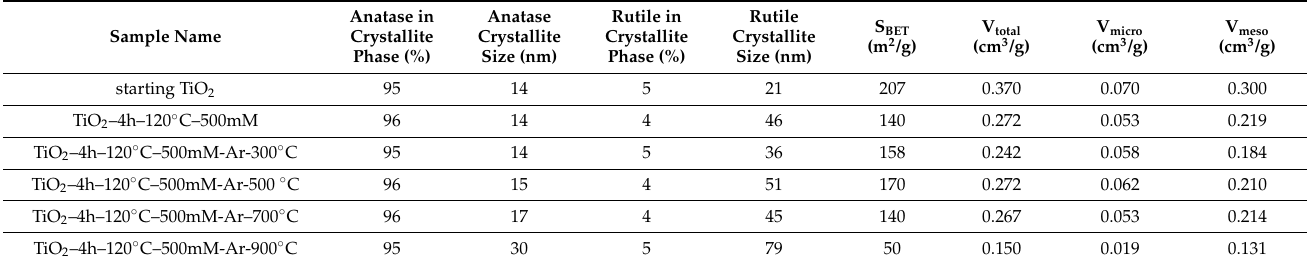
Table 1. Structural parameters of starting TiO 2 and APTES-modified photocatalysts prior and after the calcination process.